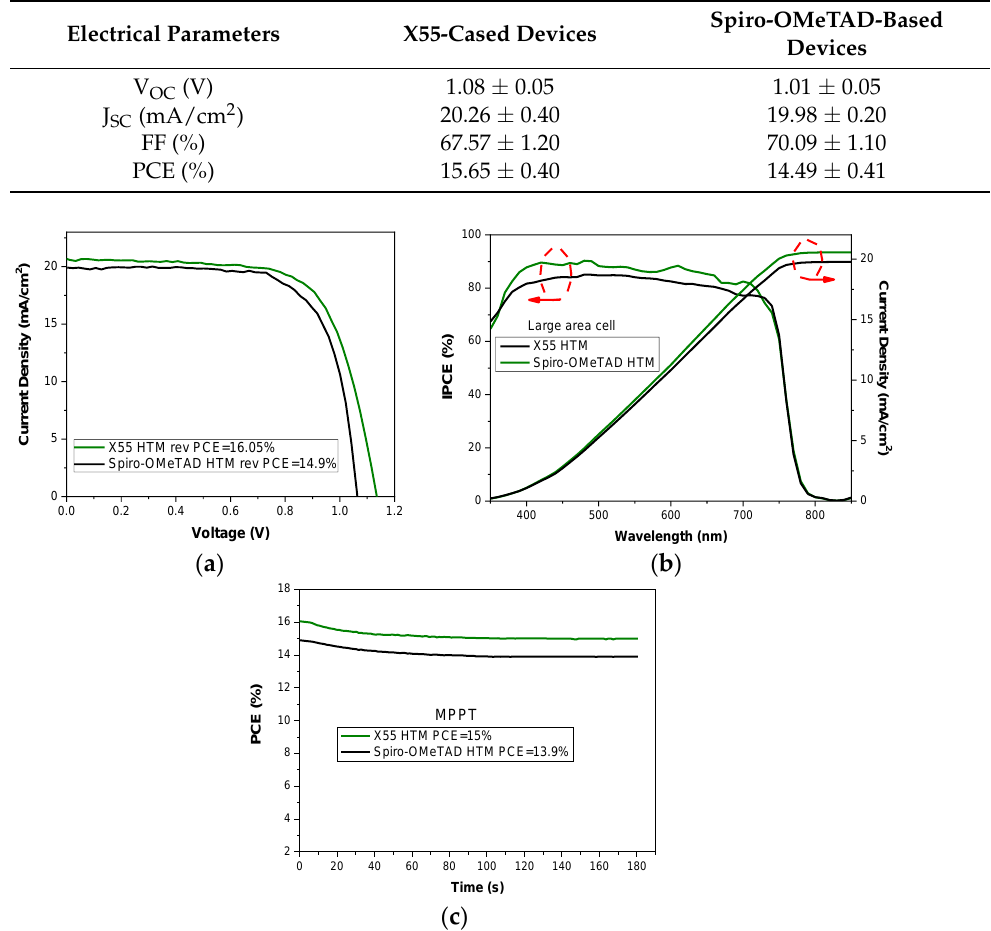
Table 2. Statistics of the fabricated large area cells: 16 with X55 HTM and 16 with Spiro-OMeTAD HTM. Electrical Parameters